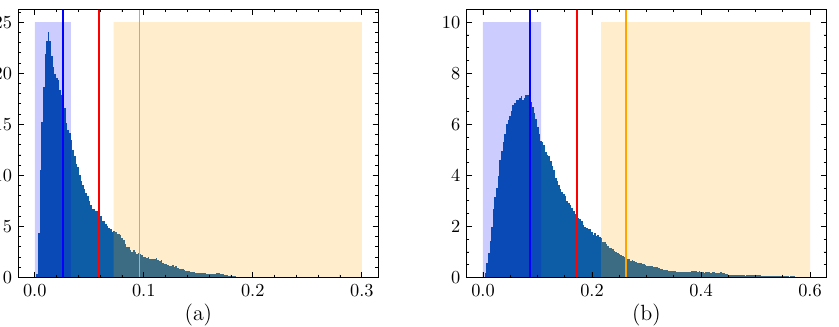
Figure 9. The Sample Distribution on the Bay Area dataset and the Santa Barbara dataset. ( a ) The Bay Area dataset. ( b ) The Santa Barbara